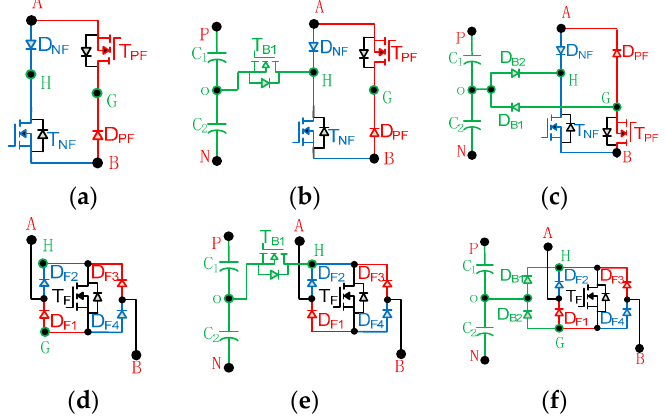
Figure 5. Indirect Connection NPC cell circuits based on topology family with an extra diode. ( a ) case #1; ( b ) NPC cell #1 under case #1; ( c ) NPC cell #2 under case #1; ( d ) case #2; ( e ) NPC cell #1 under case #2; ( f ) NPC cell #2 under case #2.